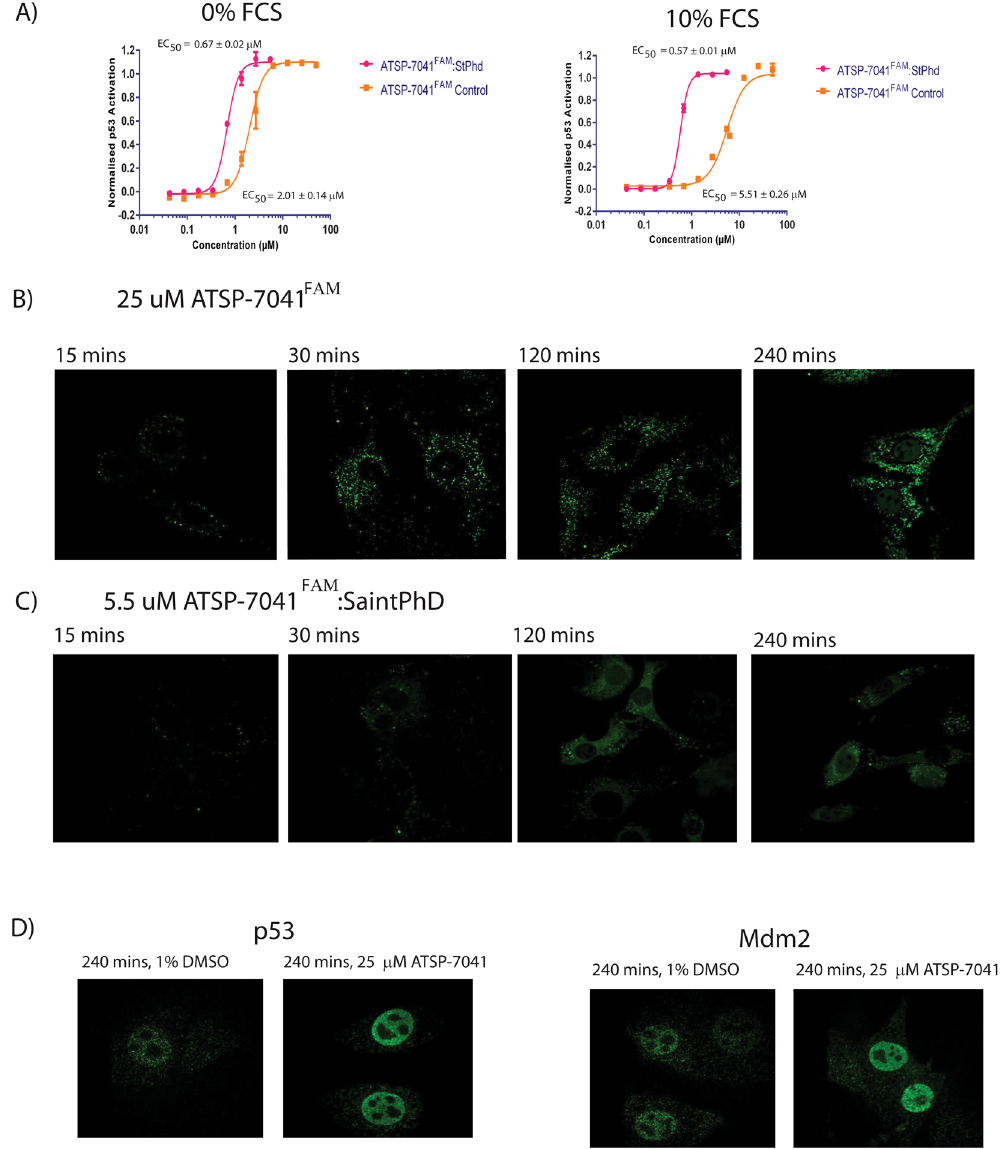
Figure 5. ( A ) ATSP-7041 FAM either formulated with Saint PhD or non-formulated was titrated onto T22 p53 reporter cells in the presence or absence of serum and p53 activity determined. ( B ) Time course experiment showing cellular uptake of non-formulated ATSP-7041 FAM at a peptide concentration of 25 µ M into T22 cells in the presence of 10% FCS, which have been pulse labeled at different time intervals. ( C ) Time course experiment showing cellular uptake of ATSP-7041 FAM :SAINTPhD at a peptide concentration of 6 µ M into T22 cells with 10% FCS present, which have been pulse labeled at different time intervals. ( D ) Fixed T22 cells were stained for Mdm2 and p53 protein levels after 4 hour treatment with either 1% DMSO or 25 uM ATSP-7041 in the presence of 10%